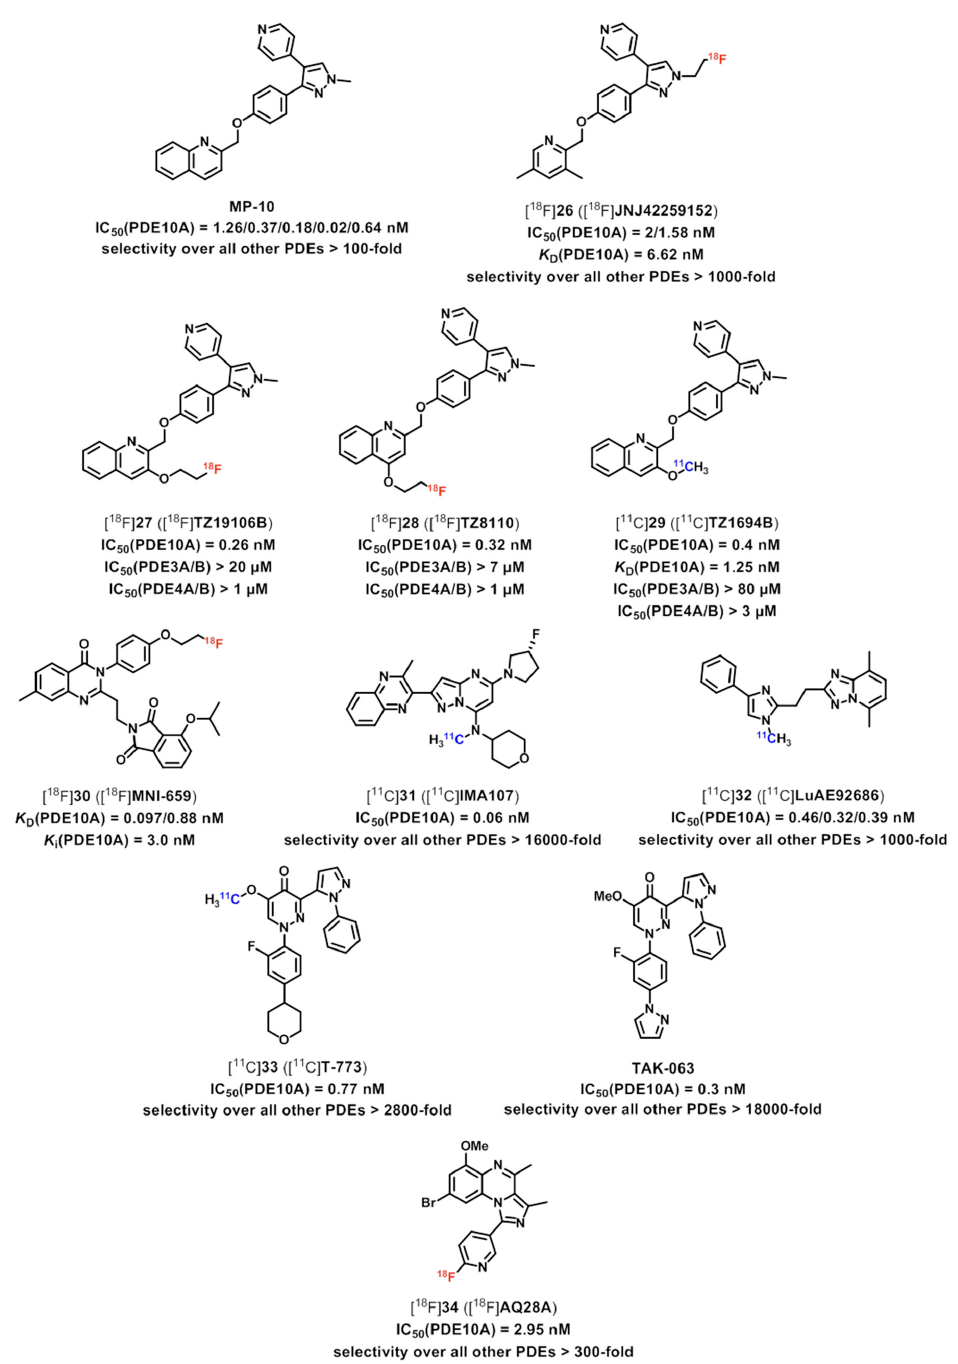
Figure 6. Molecular structures and IC 50 or K D / K i values for PDE10A of the PDE10A inhibitor MP-10 [110,114–117], the MP-10 -derived ([ 18 F]) 26 [111,112,117,118], ([ 18 F]) 27 and ([ 18 F]) 28 [119], ([ 11 C]) 29 [120,121], and the not MP-10